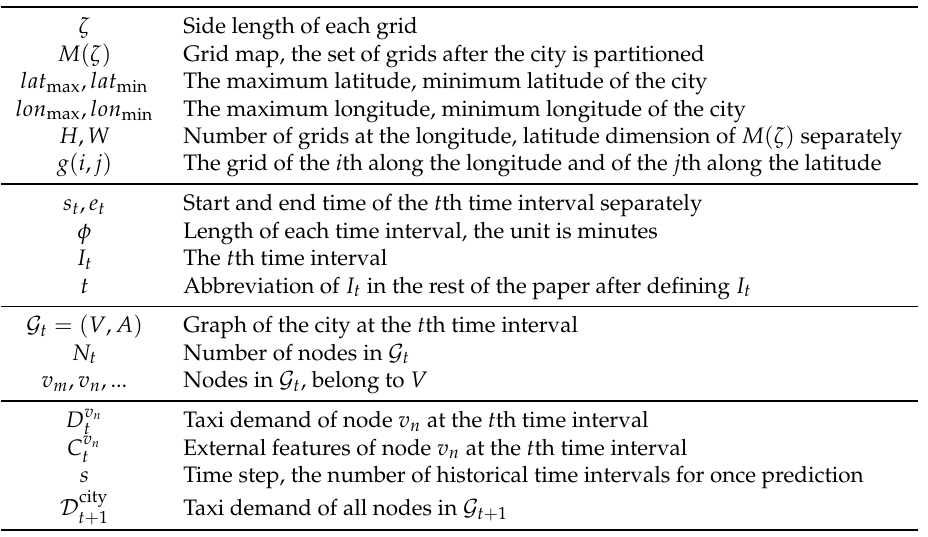
Table 1. Symbols and notations.